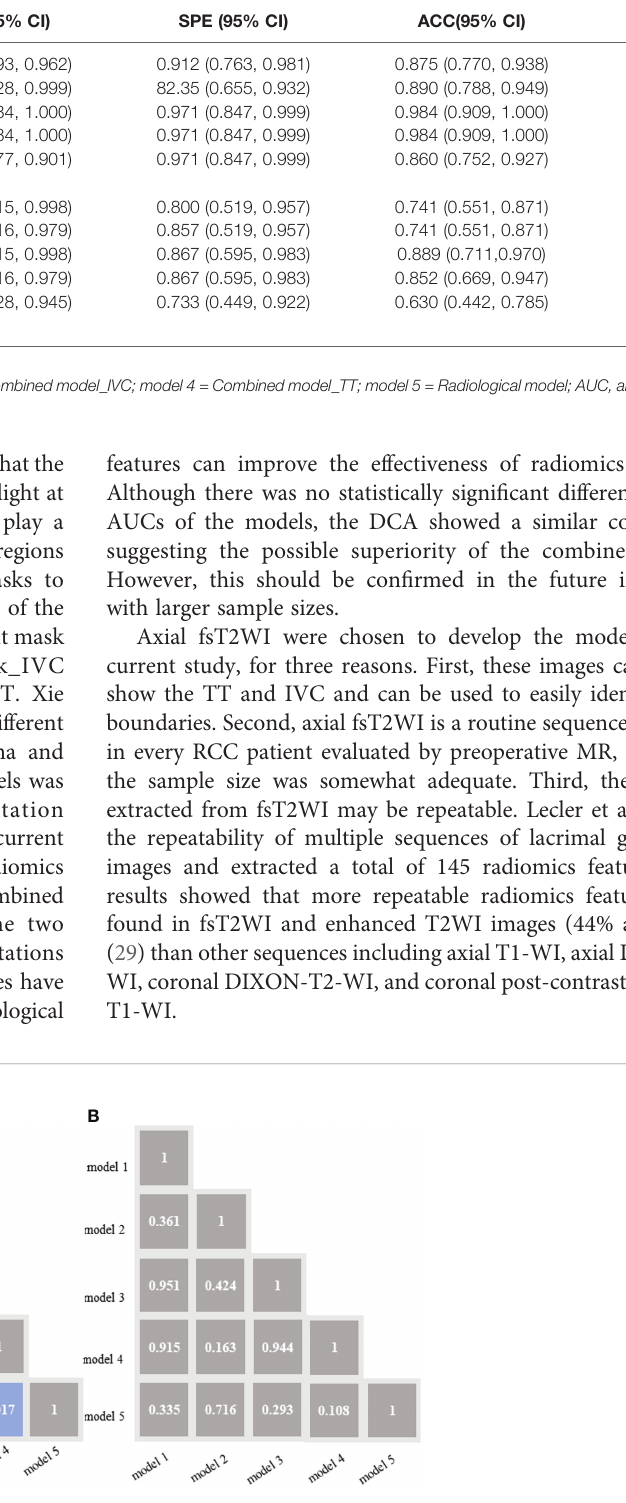
TABLE 4 | The fi ve models ’ performance in predicting inferior vena cava wall invasion by tumor thrombus.